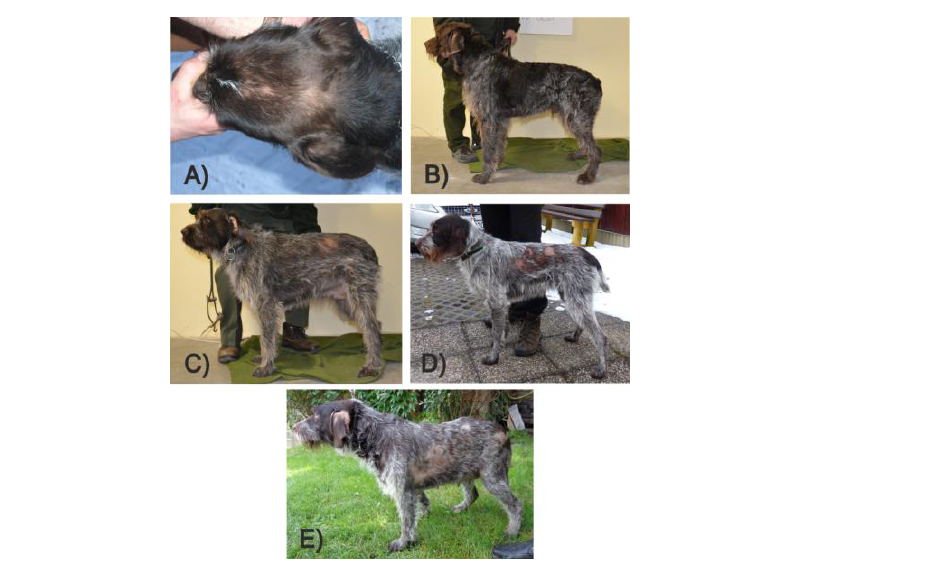
Figure 1. Cesky Fousek individuals affected by aRFA. ( A ) unusual manifestation on the head; ( B ) level 1 aRFA—loss of hair on ears only; ( C ) level 2 aRFA—loss of hair on the body sides up to approximately 10 × 10 cm; ( D ) level 3 aRFA—loss of hair on the body sides up to approximately 10 × 25 cm; ( E ) level 4 aRFA—loss of hair of the body sides up to approximately 10 × 40 cm. Pictures A and E were taken prior to the hair-loss peak in these individuals; alopecia worsened in the weeks after the pictures were taken.